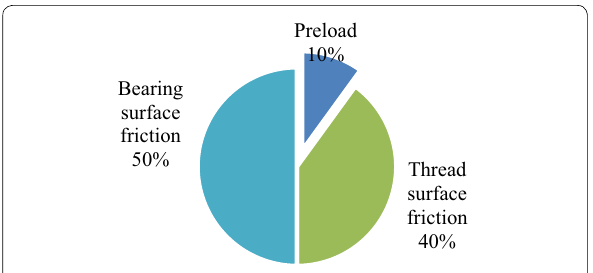
Figure 4 Distribution of torque consumption during bolt tightening